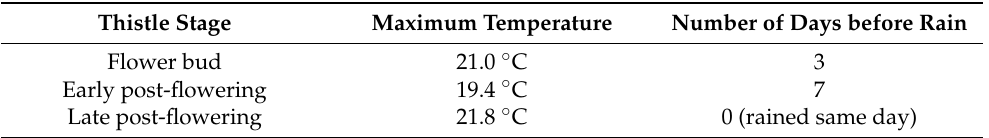
Table 2. The maximum temperature on the day of application and number of days after treatment before the onset of